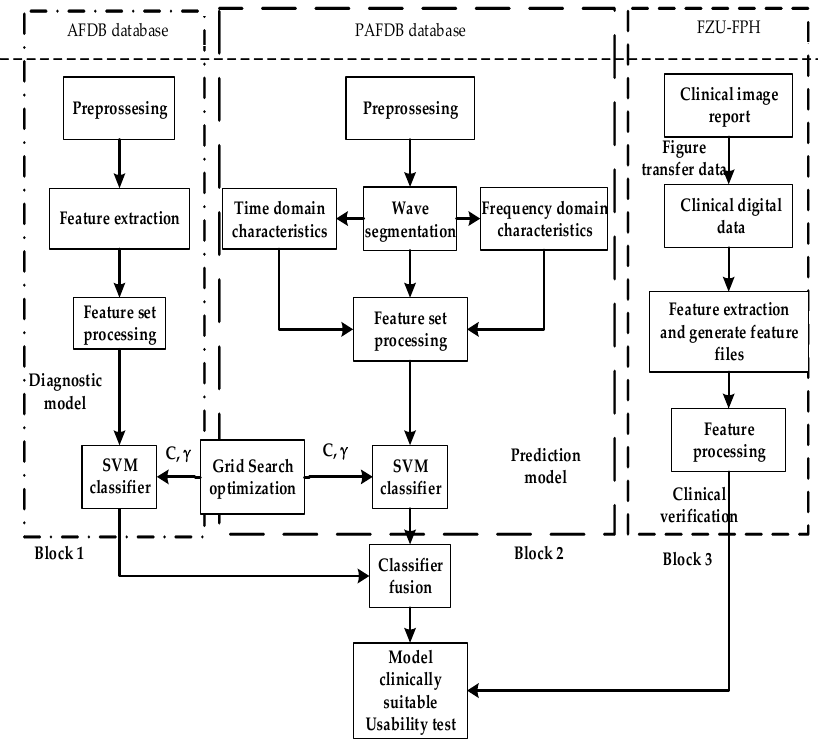
Figure 1. Overall implementation of the ECG analysis algorithm with atrial fibrillation.